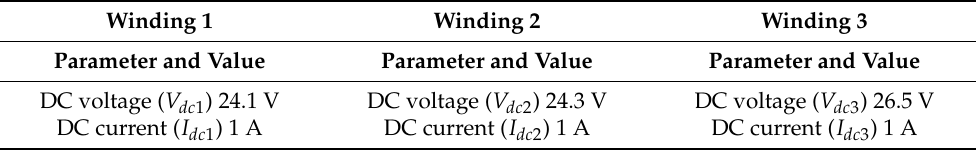
Table 9. Obtained values of the DC-test carried out by independent sets at the asymmetrical nine- phase